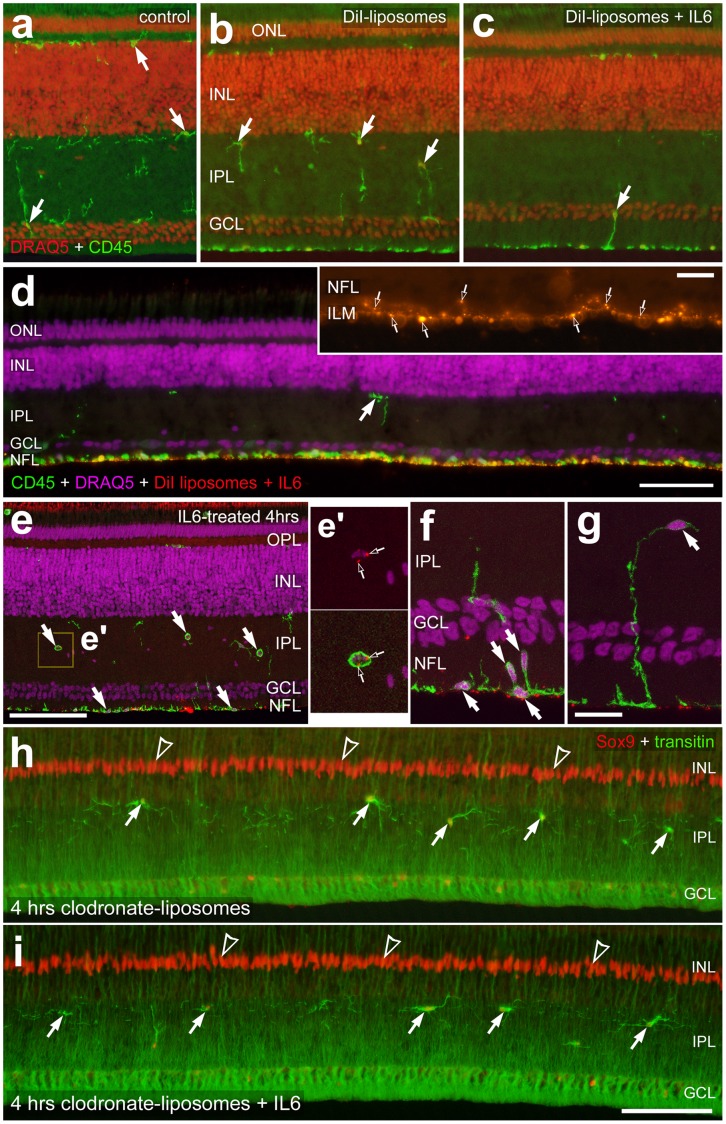
Clodronate-DiI-liposomes accumulate, along with the microglia, at the vitread surface of the retina, whereas the NIRG cells appear unaffected by short-term exposure to IL6 and liposomes.Vertical sections of the retina were labeled with DRAQ5 (red, a–c; magenta, d–g) and antibodies to CD45 (green, a–g), Sox9 (red, h and i), and transitin (green, h and i). The red fluorescent puncta in panels d–g are DiI-labeled liposomes. Images were obtained by using wide-field (a–c, inset in d, h and i) or confocal (d–g) microscopy. Images were obtained from eyes that were treated with saline (a), clodronate-DiI-liposomes (b and h), or the combination of clodronate-DiI-liposomes and IL6 (c–g and i). Arrows indicate the somata of microglia or NIRG cells, hollow arrows indicate DiI-liposomes, and hollow arrow-heads indicate the nuclei of Müller glia. The scale bar (50 µm) in panel d applies to d alone, the bar in e applies to a–c and e, the bar in i applies to h and I, and the bar (10 µm) in the inset in panel d applies to the inset alone. Abbreviations: ONL – outer nuclear layer, OPL- outer plexiform layer, INL – inner nuclear layer, IPL – inner plexiform layer, GCL – ganglion cell layer, NFL – nerve fiber layer, ILM – inner limiting membrane.